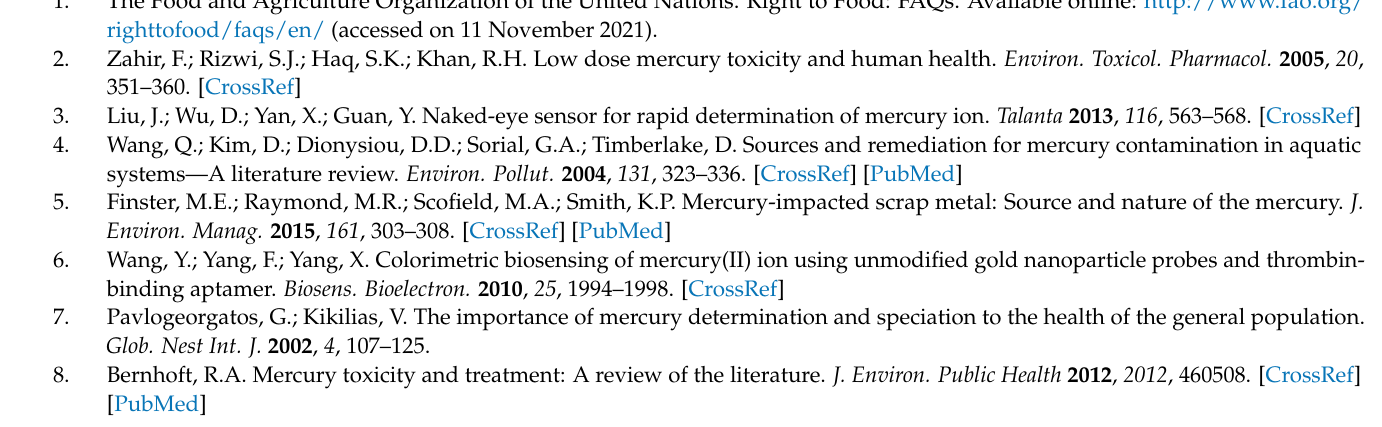
Figure S6. Scheme of µ PAD detection procedures. Table S1. Comparison of detection results for different reaction volume ratios. Table S2. Shelf life test: paper-based chip coated with AgNPs stored for 1–7, 14, 21, and 28 days. Table S3. Method comparison between µ PADs, UV–Vis, and